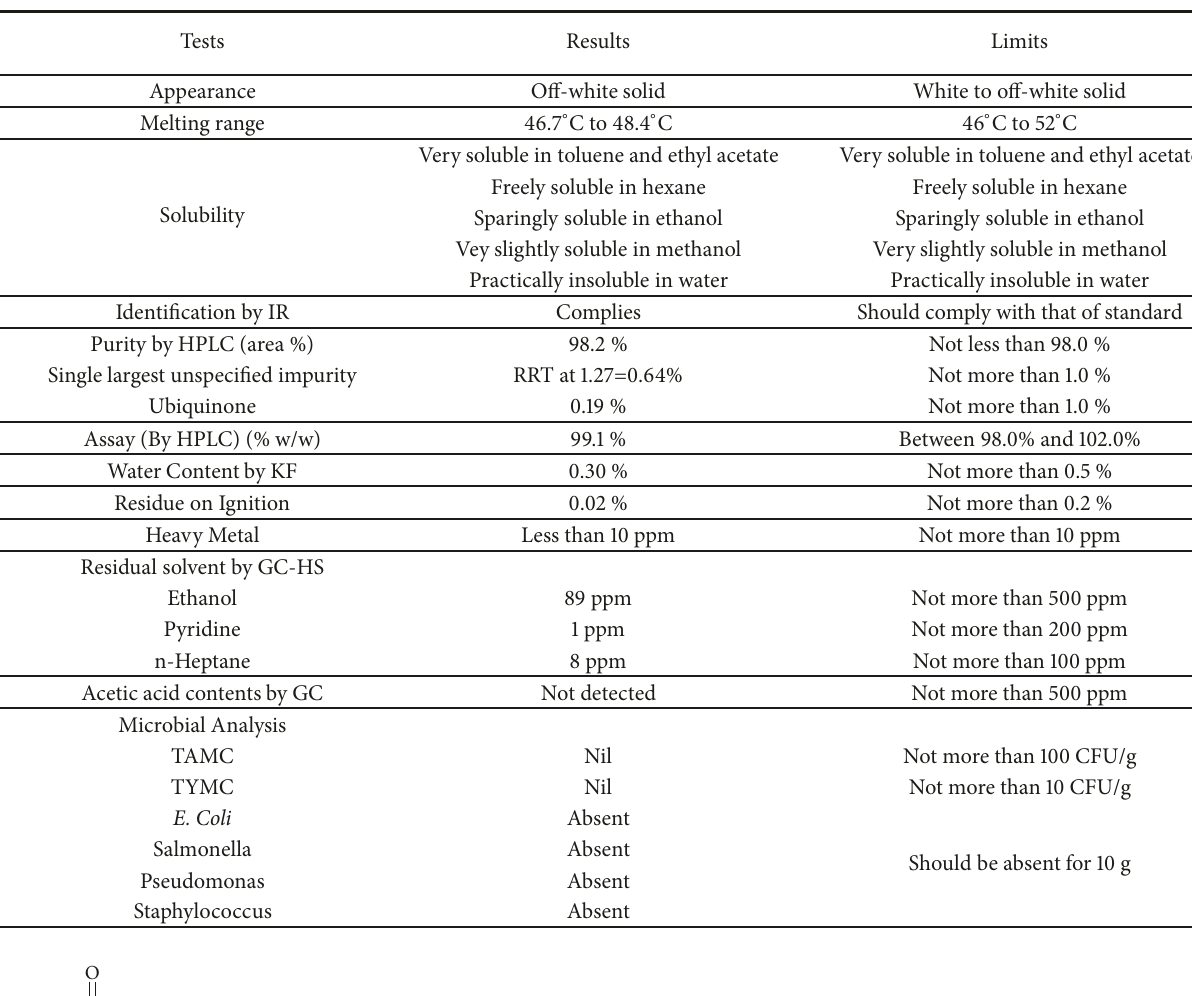
Table 2: Specifications & certificate of analysis of the ubiquinol acetate.